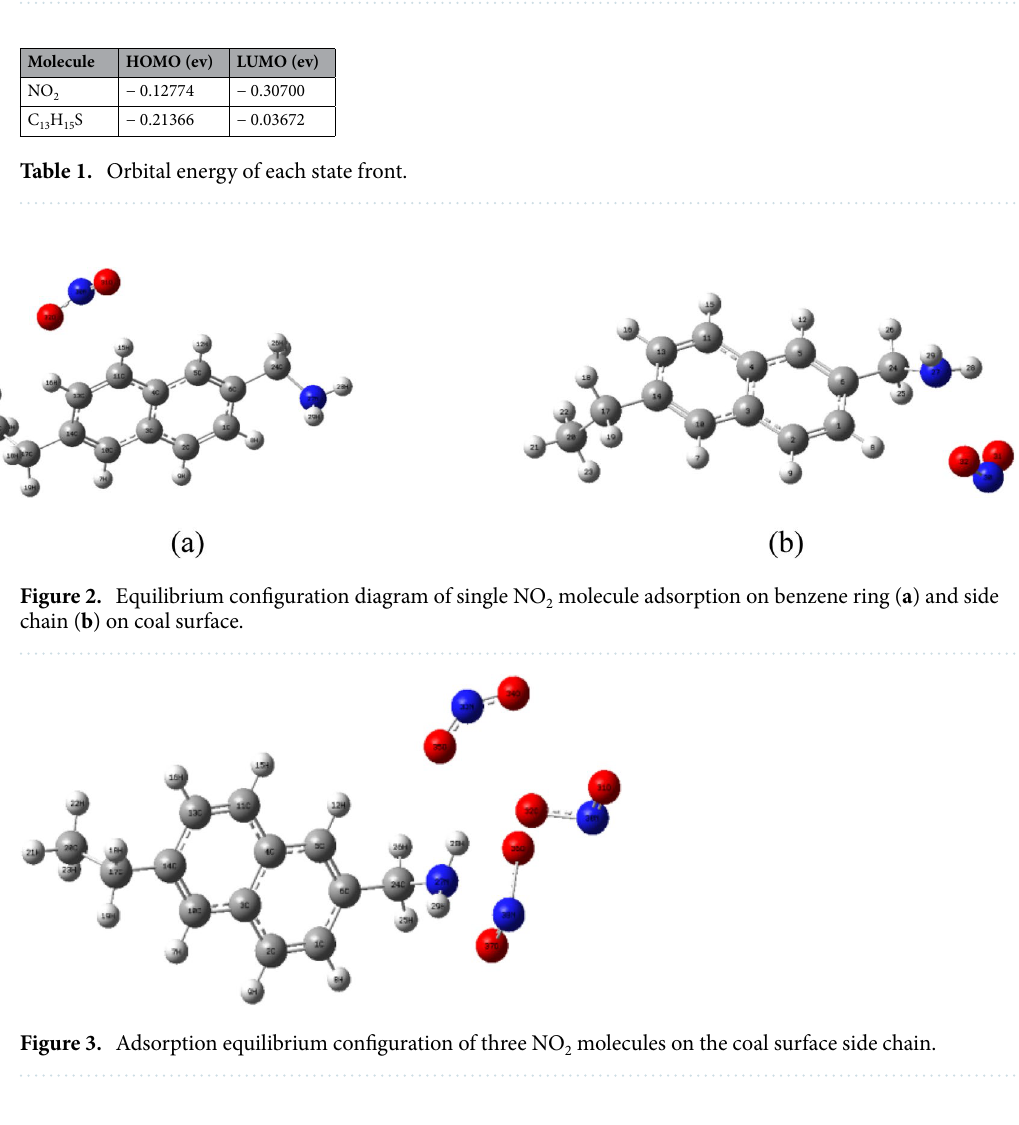
Figure 1. Geometrically balanced configuration of coal surface ( a ) and NO 2 molecule ( b ).